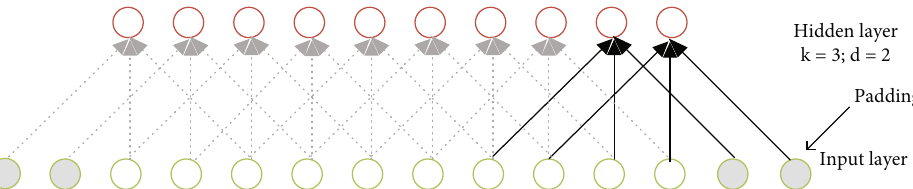
Figure 6: Visual structure diagram of the expanded convolutional